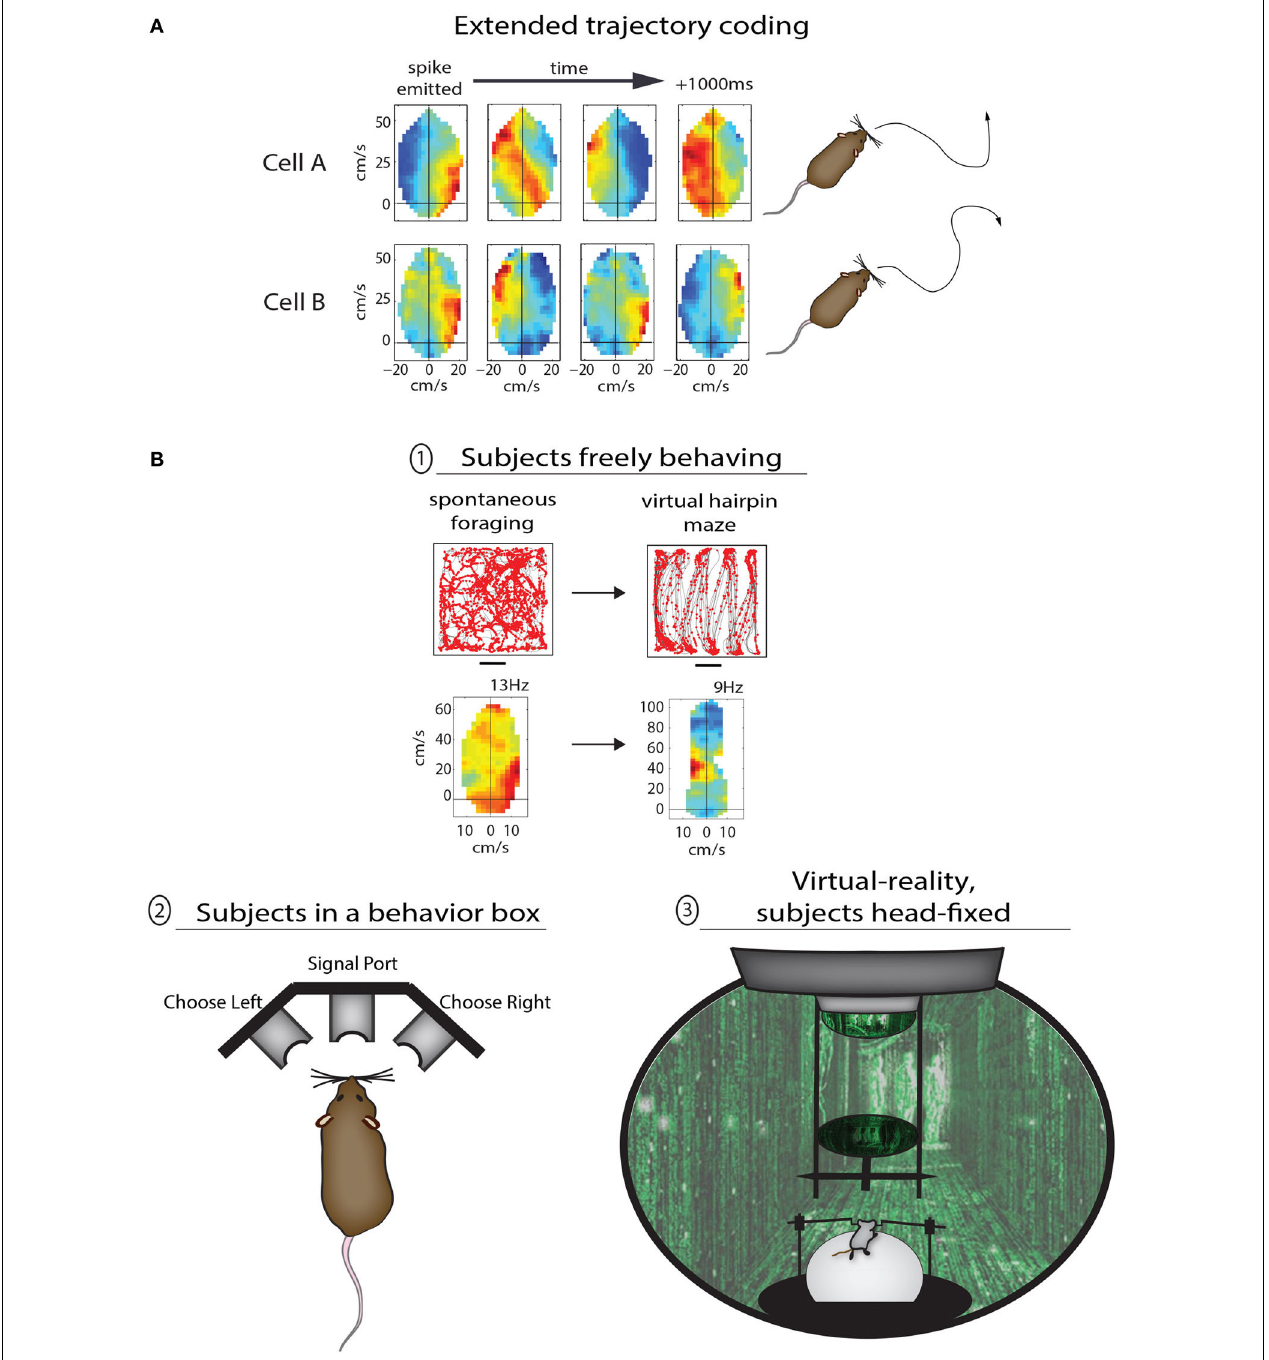
FIGURE 2 | Methods for studying the various functions of PPC in rodents. (A) Two examples of PPC cells coding sequential trajectories during unrestrained foraging in the open field. Cell A fired when right turns were followed by sustained turning to the left; the motion sequence coded by the cell is illustrated to right (traced from open field data). Cell B fired bursts at the start of right-left-right-right movement sequences lasting more than 1s. (B) Different levels of behavioral control for studying PPC in rodents. In the top example animals were freely foraging or performing stereotypical running sequences in the same open arena; the advantage to the lack of behavioral constraints here is the ability compare the coding properties of PPC neurons